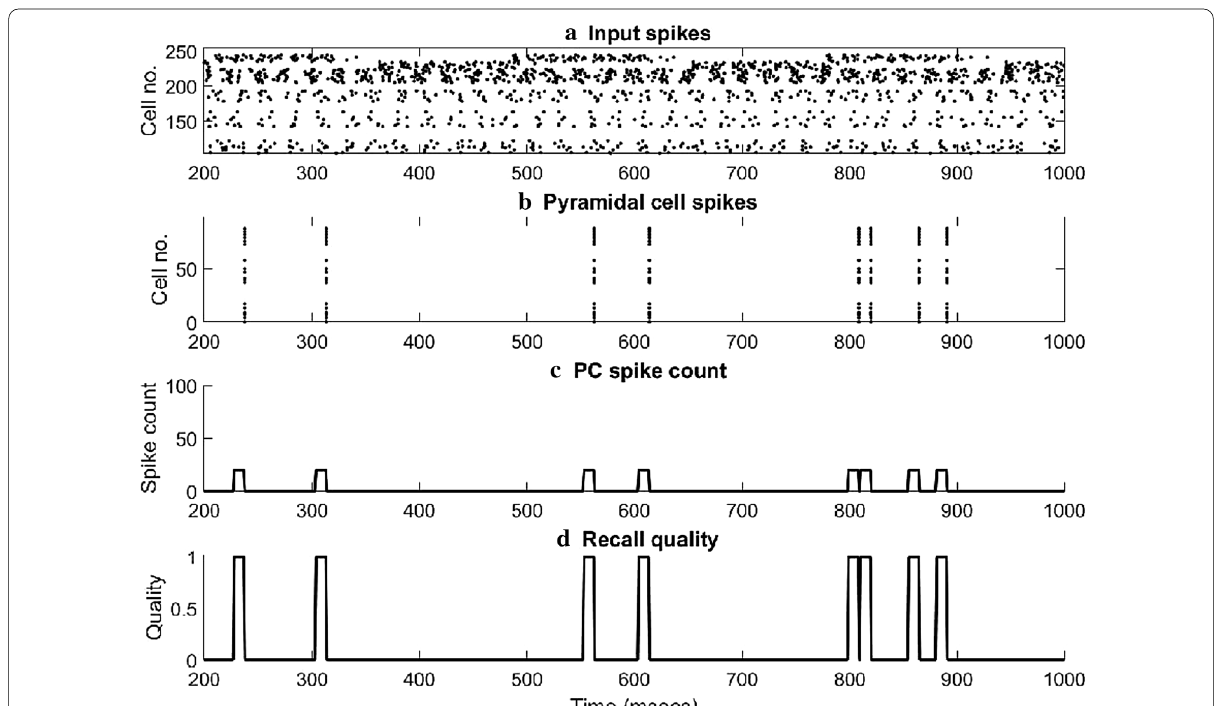
Fig. 4 a Raster plot showing septal (top 20) and CA3 input (bottom 100) spikes. b Raster plot showing 20 ‘active cells’ activity coding for a particular memory pattern. c Twenty ‘active cells’ spike count in a sliding 10 ms bin. d Recall quality in a sliding 10 ms